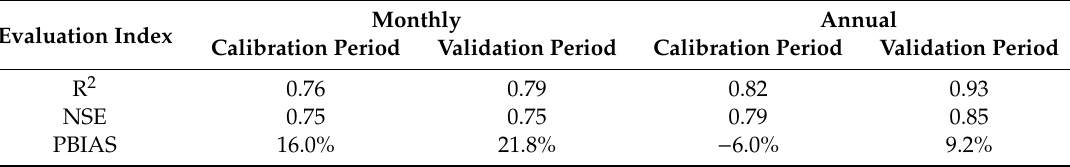
Table 3. The contribution evaluation of climate variability and forest change on runoff depth.